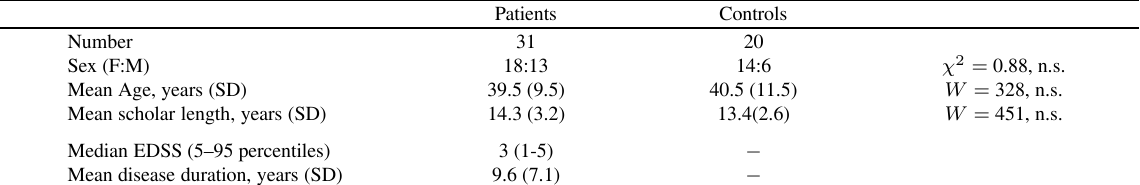
Table 2 Demographic and clinical characteristics of MS patients and control subjects. Results of Fisher ( χ 2 statistics) and Wilcoxon ( W statistics)